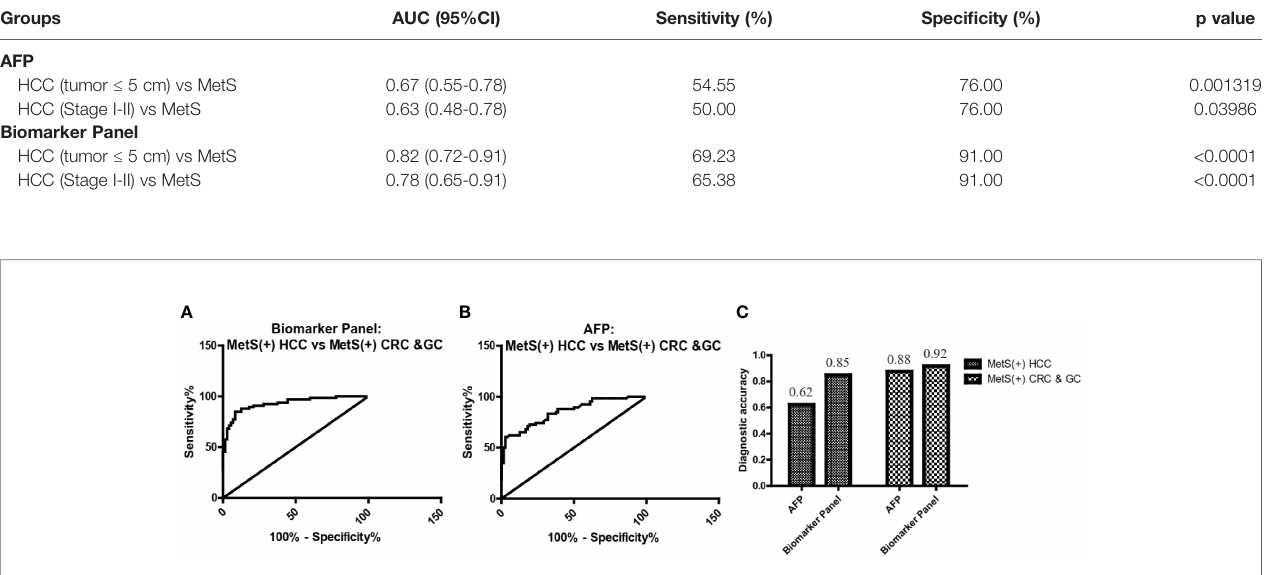
FIGURE 6 | The speci fi city of the biomarker panel in the diagnosis of MetS(+) HCC patients. (A) The ROC curve of the biomarker panel for discriminating MetS(+) HCC patients from MetS(+) CRC & GC patients. (B) The ROC curve of AFP for discriminating MetS(+) HCC patients from MetS(+) CRC & GC patients. (C) The diagnostic accuracy of AFP and the biomarker panel for the diagnosis of MetS(+) HCC and MetS(+) CRC & GC, respectively. ROC, receiver operating characteristic.